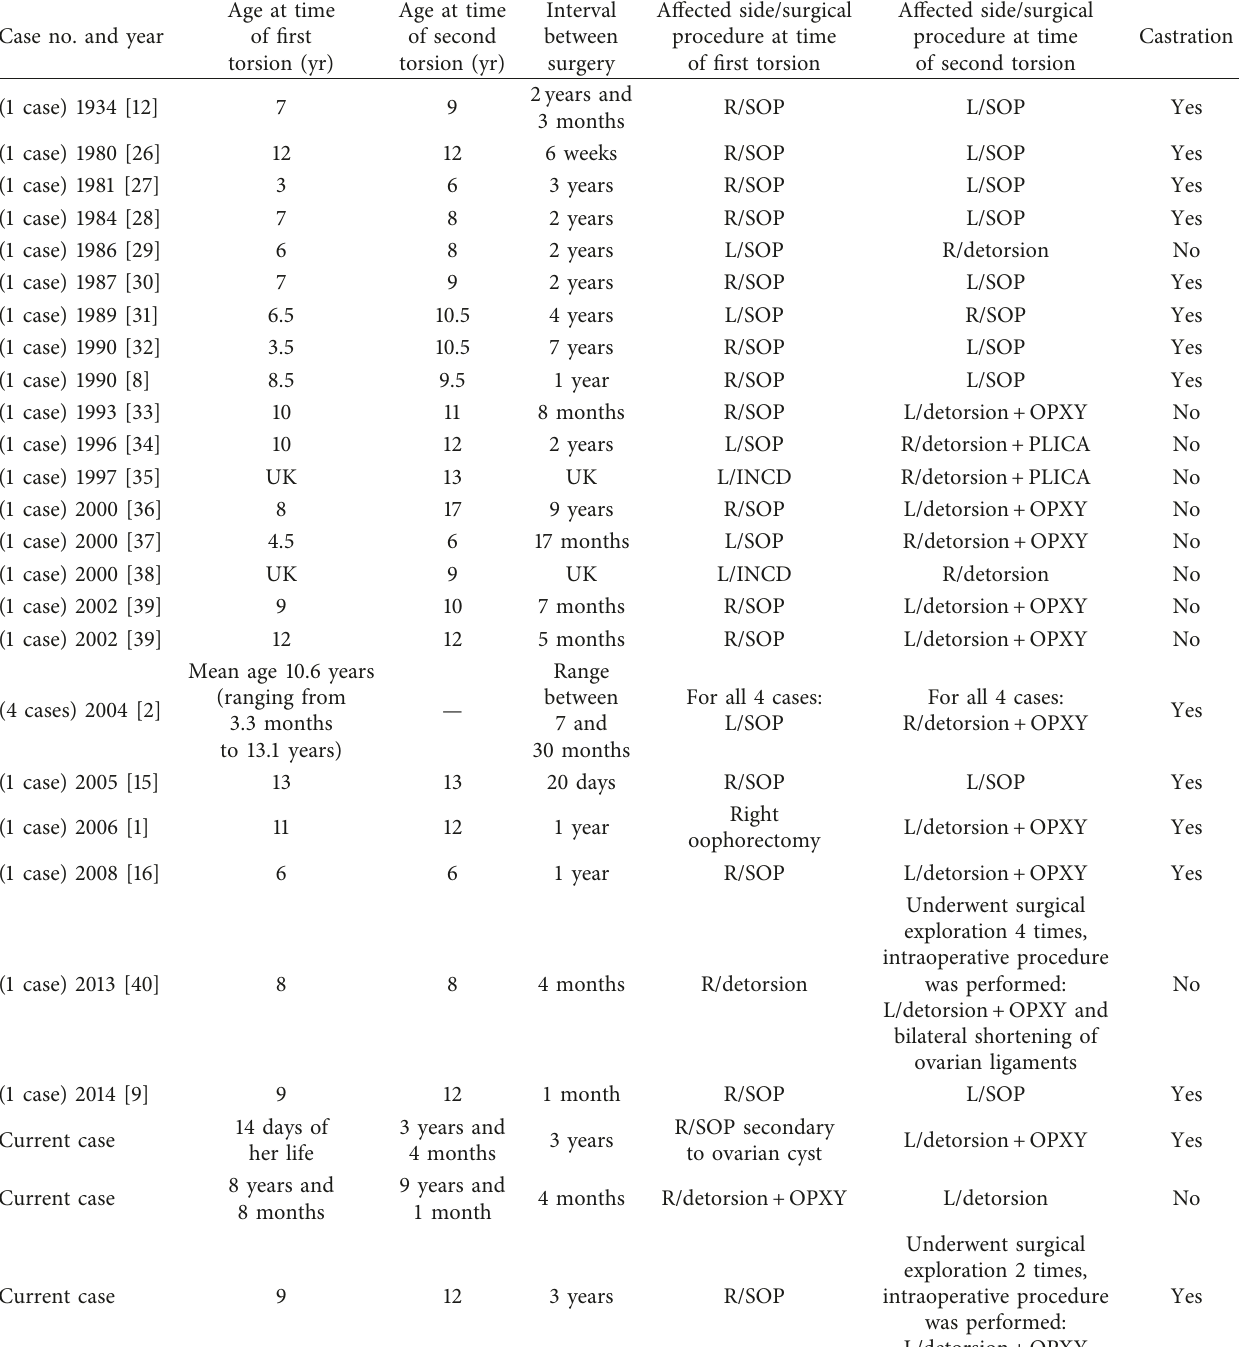
Table 2: Reported cases of ABOT in the premenarchal age